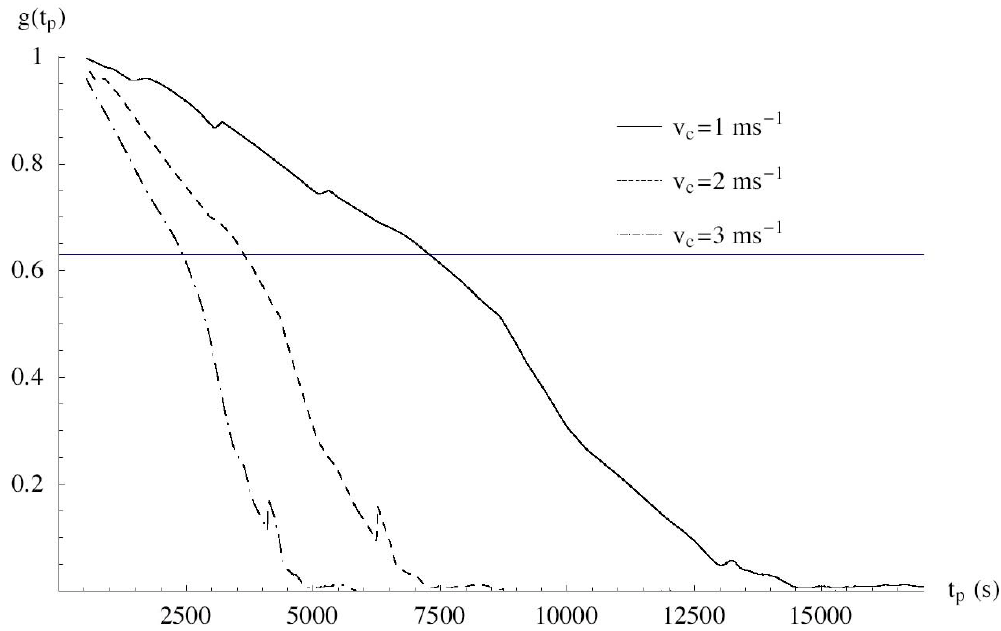
Fig. 4. Graphical solution of Eq. (9) for three values of channels celerity u c . The value of m = 0 . 63 (horizontal line) is found by analysing the extreme precipitation in the area of the Longo watershed (Italy); the other curves represent the function g(t p ) given by Eq. (9) with different channel velocities. By increasing the velocity the time to peak decreases and the peak discharge increases. However the area contributing to the peak flow remains constant in all of the three cases.